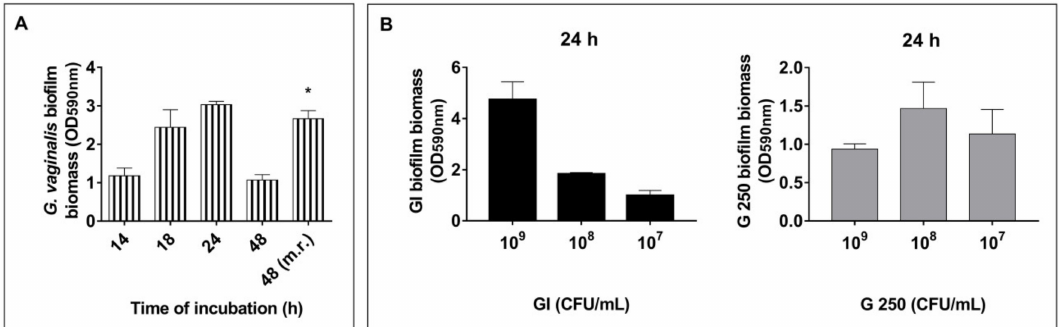
Figure 1. Gardnerella vaginalis , Saccharomyces cerevisiae CNCM (French National Collection of Cultures of Microorganisms) I-3856 (GI), and Lacticaseibacillus rhamnosus GG (G 250) biofilm formation: ( A ) G. vaginalis (10 8 colony forming units (CFU) / mL) biofilm formation after 14, 18, 24, and 48